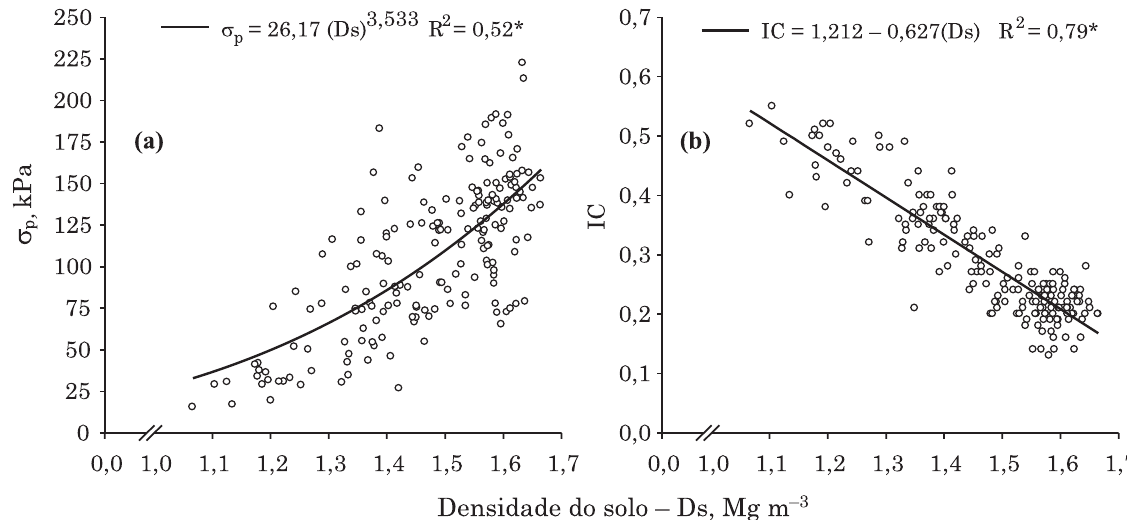
Figura 1. Tensão de pré-consolidação – σσσσσ p (a) e índice de compressibilidade – IC (b) de acordo com a densidade do solo, em todos os tratamentos e camadas avaliados.* - Modelo estatisticamente significativo 5